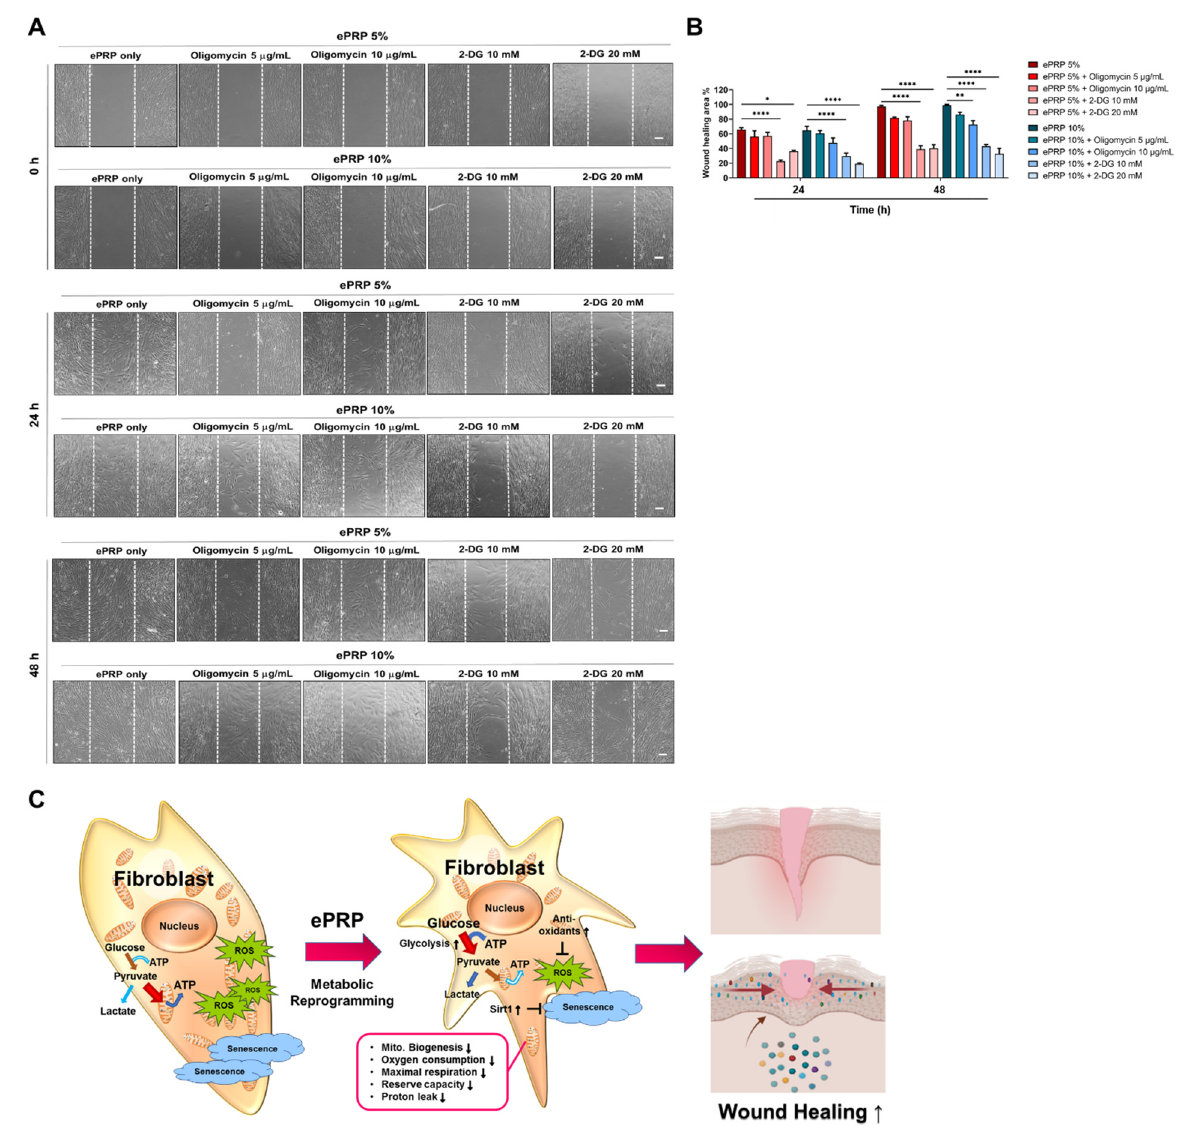
Figure 8. The glycolytic inhibitor 2-DG substantially reverses the ePRP-stimulated wound-healing ability. ( A ) After pre-treating cells with 5% and 10% ePRP for 24 h, the glycolytic inhibitor 2-DG and mitochondrial inhibitor oligomycin were applied for 48 h. Pictures of wound-healing migration were taken at 0, 24, and 48 h until full gap closure. The scale bars indicate a distance of 100 µ m. ( B ) The statistical outcomes of migration area percentage of independently repeated experiments as mean ± SEM (N = 3) were shown in bar graphs. The two-way ANOVA with Sidak’s multiple comparisons test is used to evaluate all ePRP treatments statistically (* p < 0.05, ** p < 0.01, **** p < 0.0001). ( C ) The central metabolic control of ePRP in fibroblasts is depicted in this diagram. In fibroblasts, ePRP steers metabolic reprogramming toward glycolytic energy metabolism, ensuring redox balance and enabling anabolic pathways necessary for healing and anti-ageing.